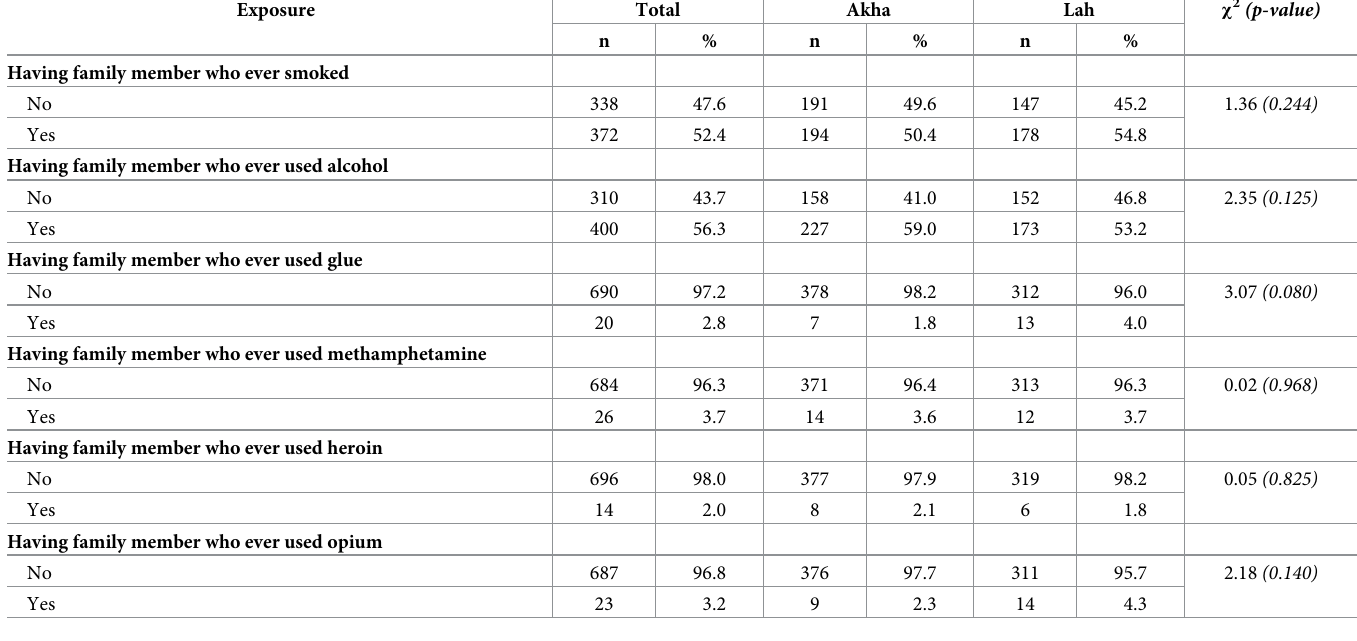
Table 2. Experiences of family members on exposing to drugs and alcohol.